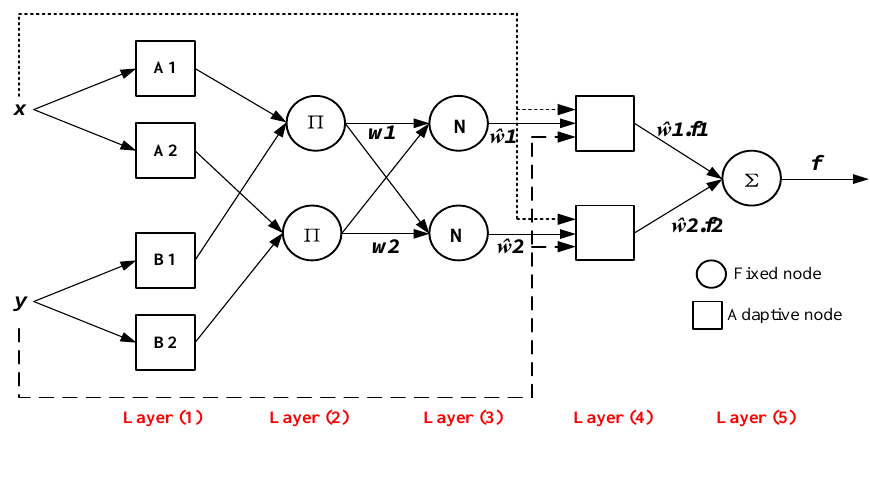
Figure 5. ANFIS architecture model.